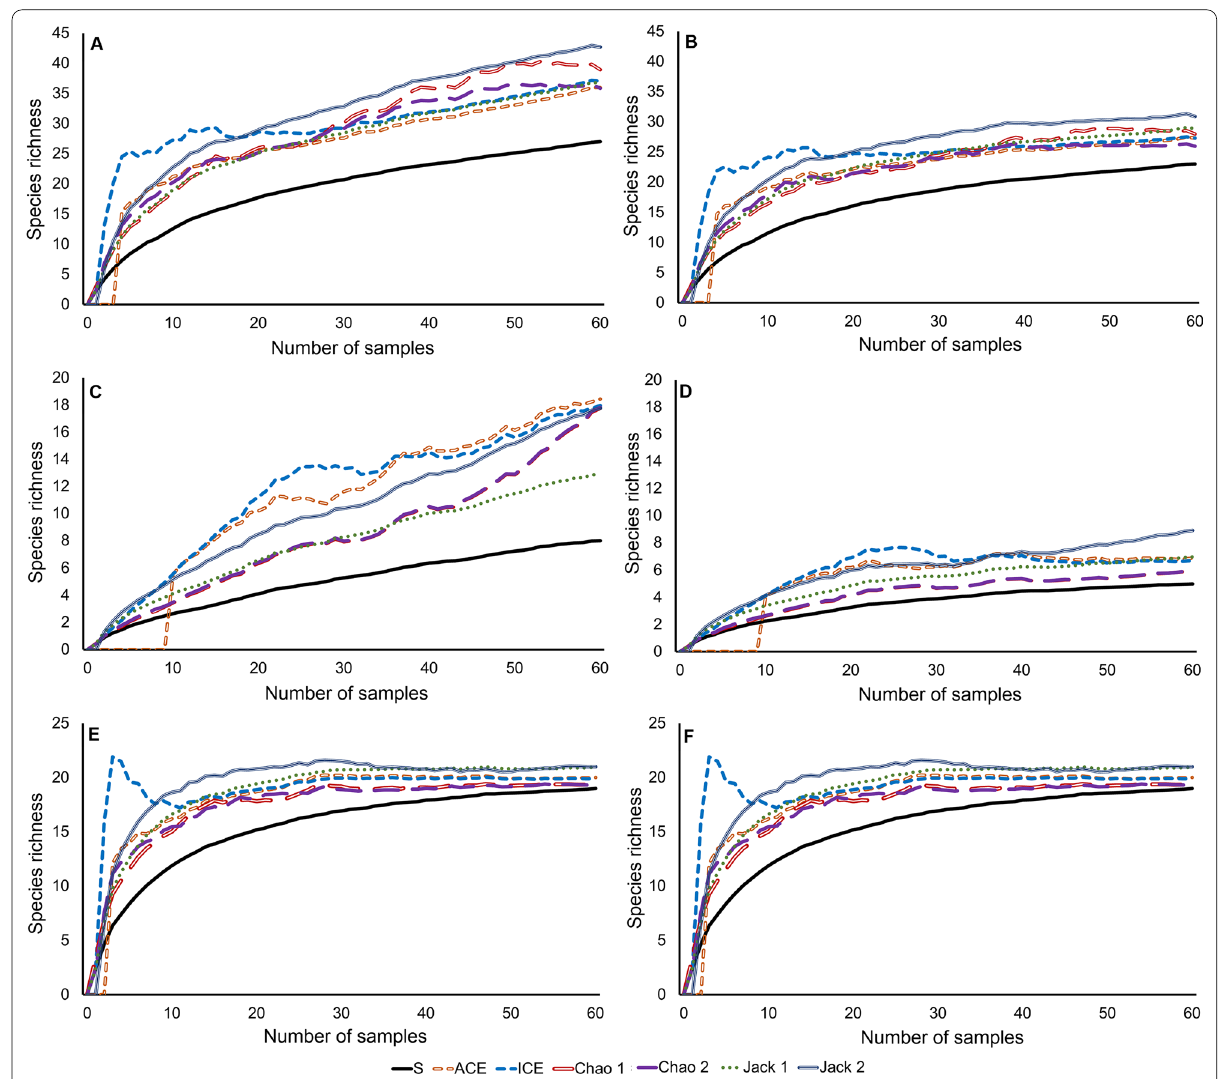
Fig. 6 Species richness estimation curves for semi-natural site 2, Chaco, Argentina, with adult grassland; A – C – E : analyses with HTS; B – D – F : analyses without